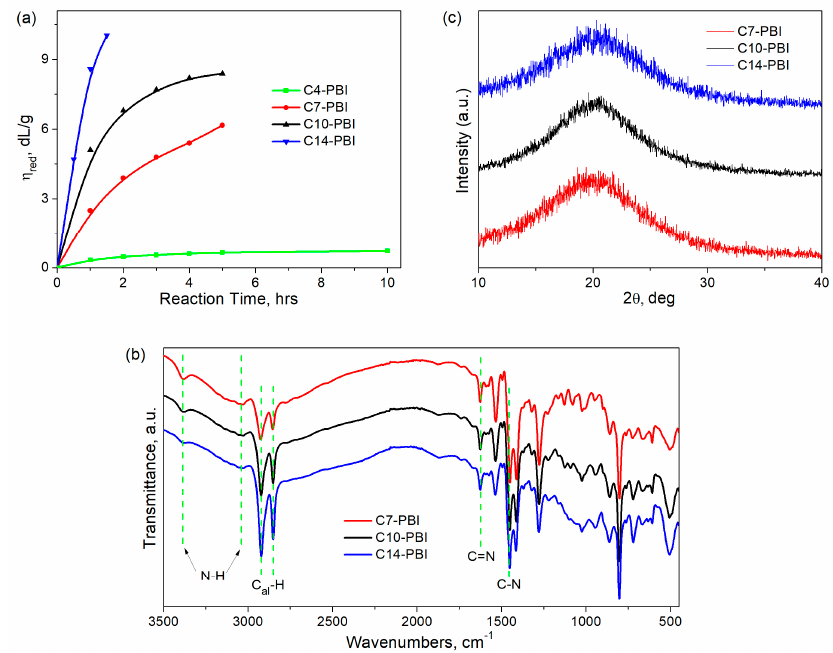
Figure 2. Effect of reaction time on reduced viscosity of PBIs, obtained by polycondensation in ER ( a ). FTIR spectra ( b ) and WAXD patterns ( c ) of PBIs. Dotted lines display the characteristic absorption bands of aliphatic PBIs.